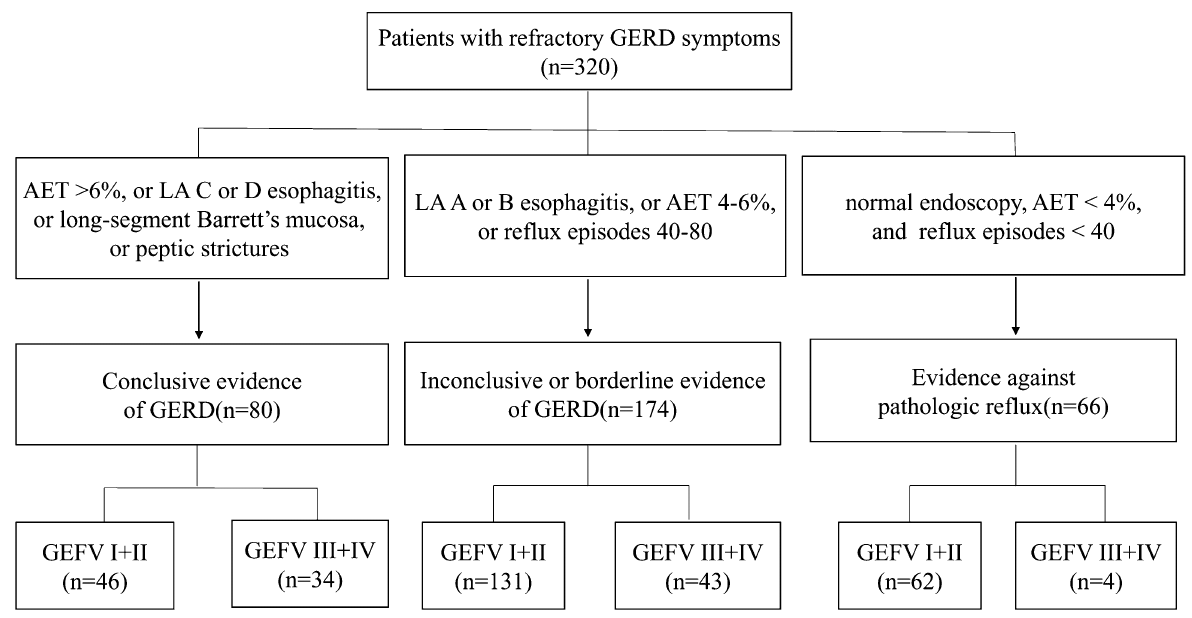
Figure 1. Flow chart of 320 patients with GERD symptoms as classified by the Lyon Consensus. GERD gastroesophageal reflux disease, AET acid exposure time, LA Los Angeles, GEFV gastroesophageal flap